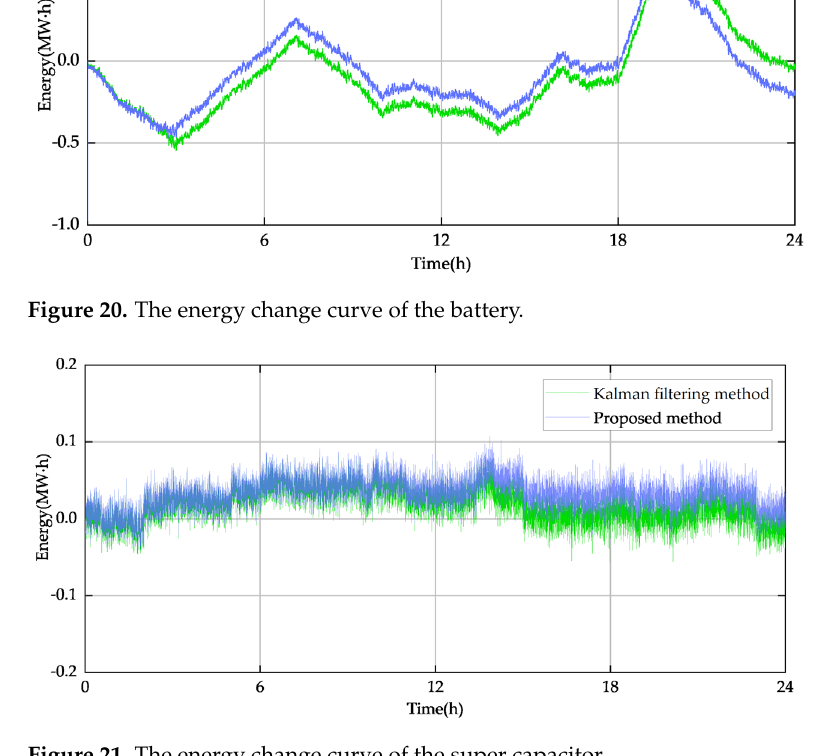
Table 3. Minimum capacity required for energy